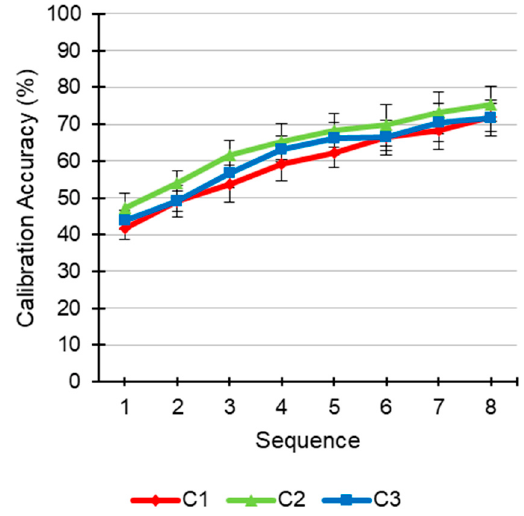
Figure 3. Accuracy (%; mean ± standard error) of each condition (C1, no speech; C2, ignoring the speech; C3, listening to the speech) as a function of the number of sequences during the calibration phase.